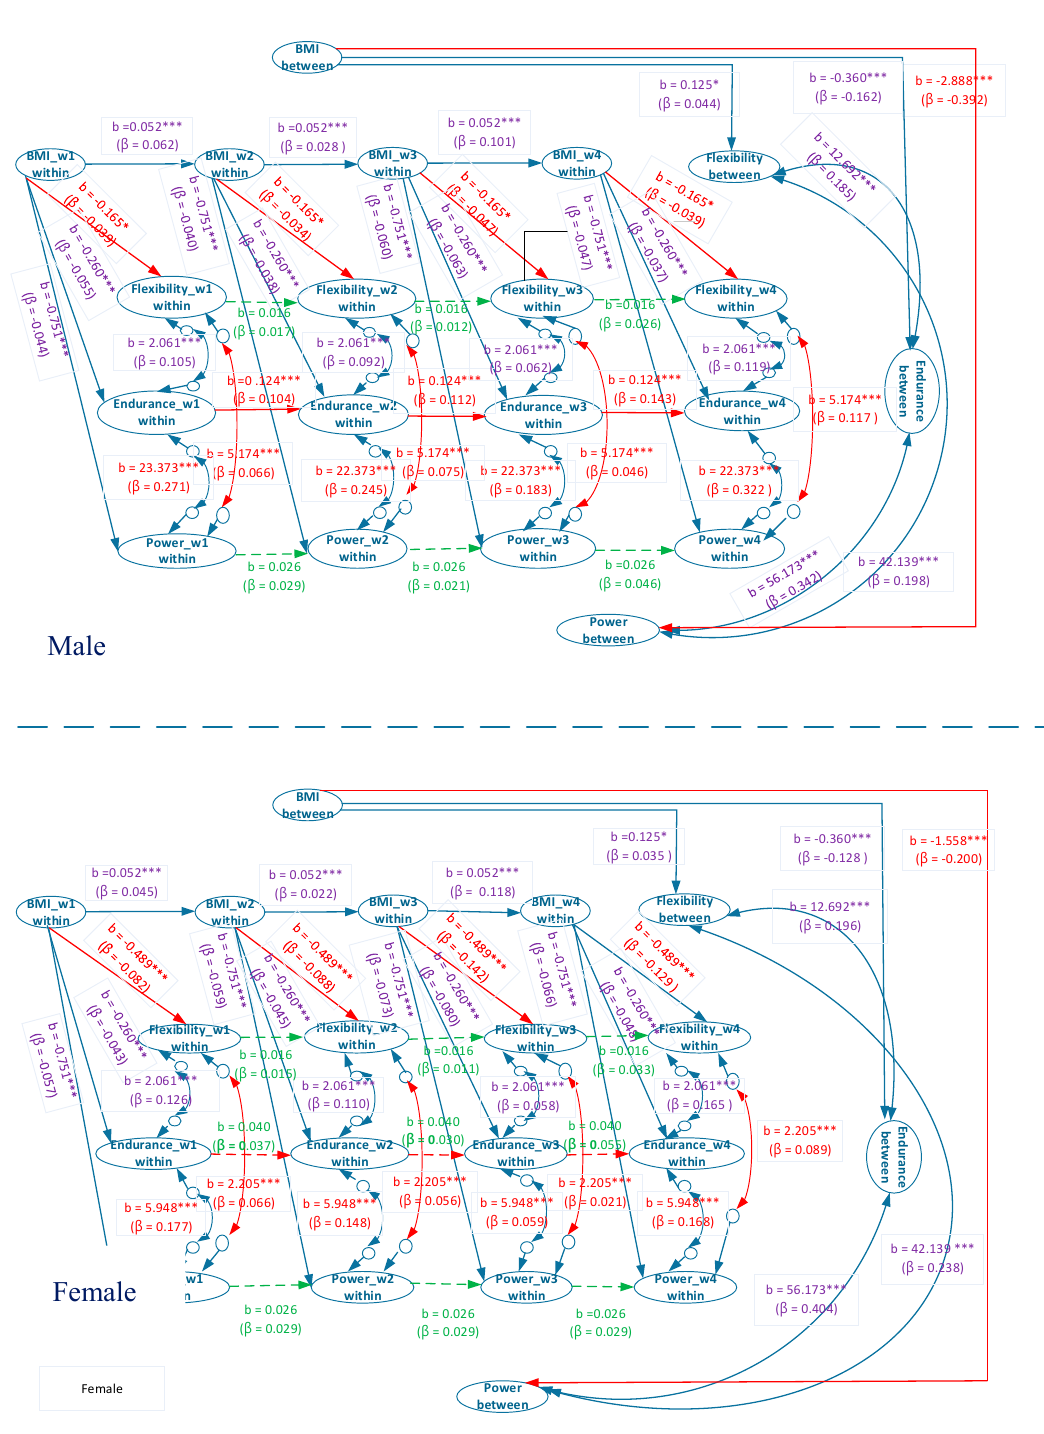
Figure 5. Simplified representation of the constrained multi-group random-intercept panel models for male and female participants.